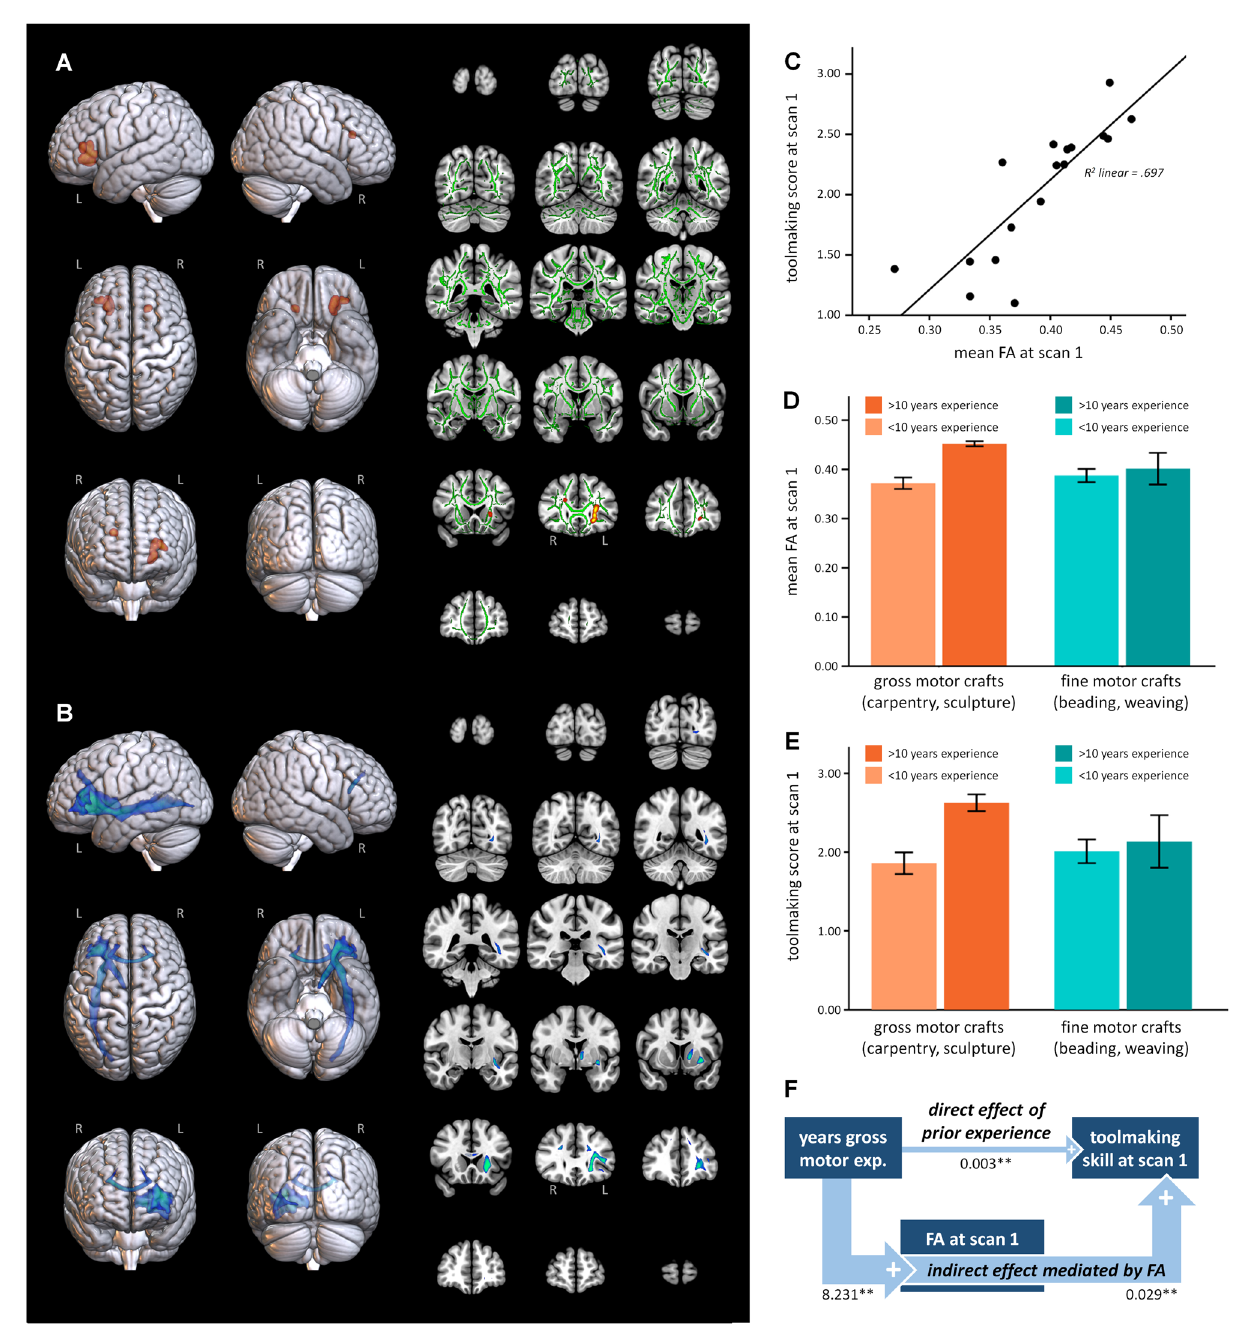
Figure 2. Baseline FA in ventrolateral prefrontal cortex is predictive of pre-training toolmaking performance. ( A ) Voxels showing a significant positive correlation between FA and toolmaking score at scan 1 are illustrated in orange. In 2D slices, the white matter skeleton is shown in green. ( B ) Probabilistic tractography from voxels showing a significant positive relationship between baseline FA and pre-training toolmaking scores. This is a composite image representing above-threshold connectivity in at least 67% of the participants. ( C ) Relationship between FA and toolmaking scores at scan 1 for the voxels indicated in ( A ). ( D ) Within these voxels, individuals with > 10 years of gross motor craft experience had significantly higher FA than subjects without this prior experience (t(15) = 2.3684, p = .002). This relationship did not hold for prior experience with fine motor crafts (t(15) = 0.465, p = .649). ( E ) Individuals with > 10 years of gross motor craft experience also had significantly higher toolmaking scores before training began (t(15) = 2.947; p = .010). Again, this relationship was not significant for fine motor craft experience (t(15) = 0.382; p = .708). ( F ) A causal mediation analysis showed that the effect of prior gross motor experience on pre-training toolmaking scores occurred almost entirely via the effect of prior experience on baseline